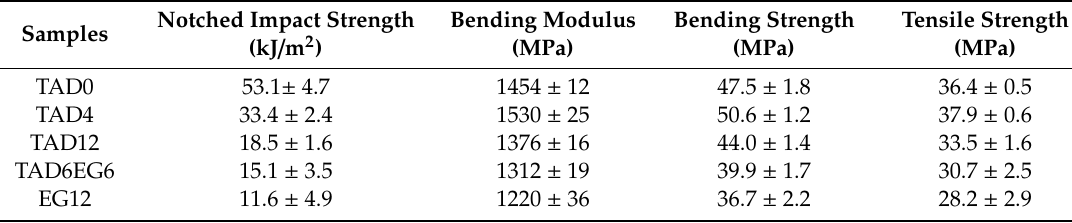
Table 5. Mechanical properties of PBT / PET blend and flame-retarded PBT / PET materials.